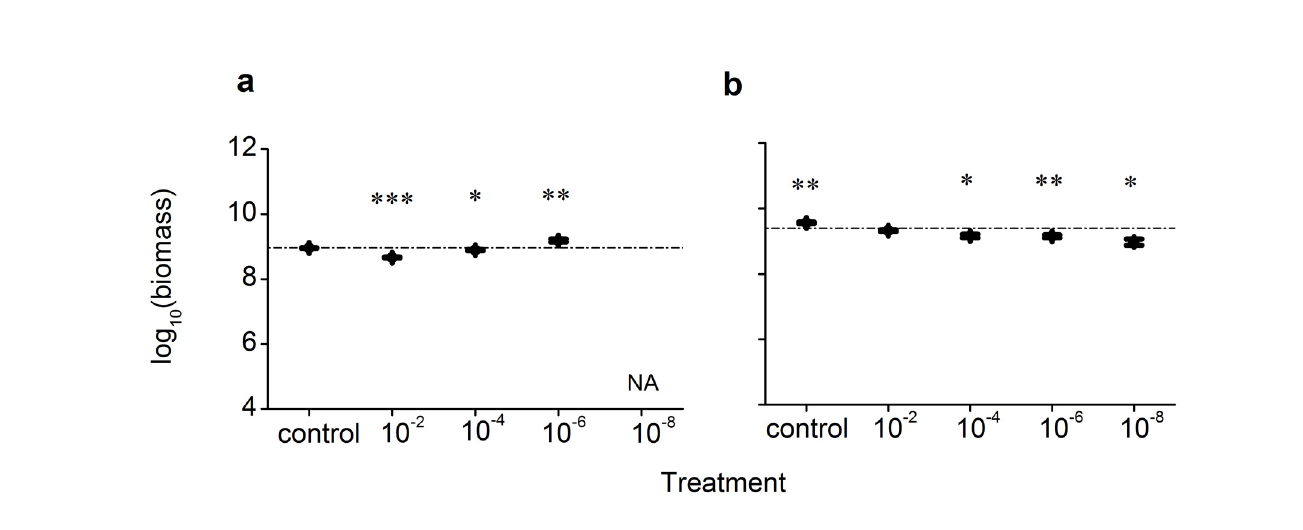
Fig 4. Bacterial community biomass in experimental microcosms. (a), the sandy soil microcosms. (b), the grassland soil microcosms. Asterisks indicate significant departure from the source soils (based on one-sample t test; single asterisk, p < 0.05; double, p < 0.01; triple, p < 0.001). Data show mean ± SE (n =